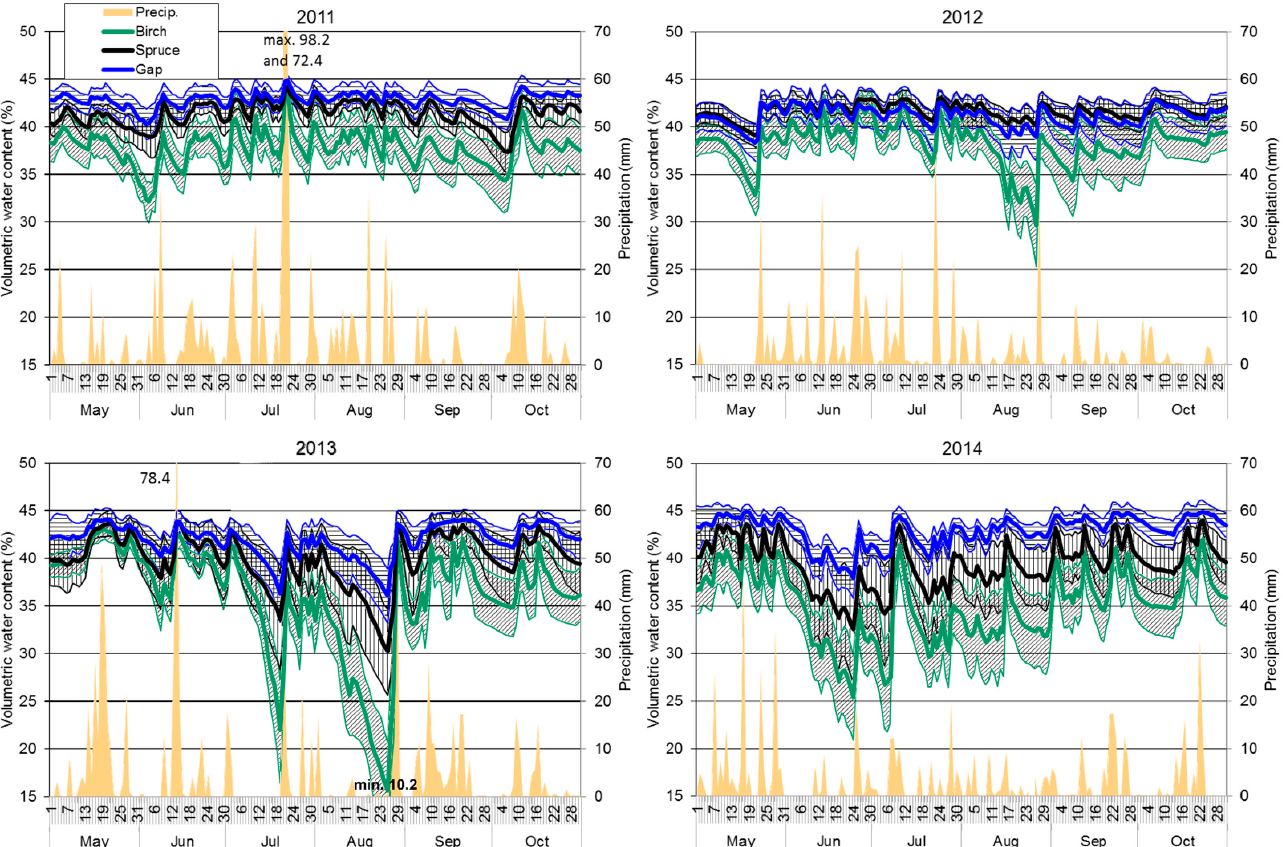
Figure 5. Precipitation (mm day − 1 ) and the average volumetric water content of the topsoil (%; bold line) and the 95% confidence interval of the average volumetric water content expressed by pivot statistics (L 95% , H 95% ; thin line and hatching) under the spruce, birch, and gap treatments in 2011–2014 growing seasons. Any precipitation exceeding the y -axis range is presented above, while the water content value below the y -axis range is at the bottom of the chart.